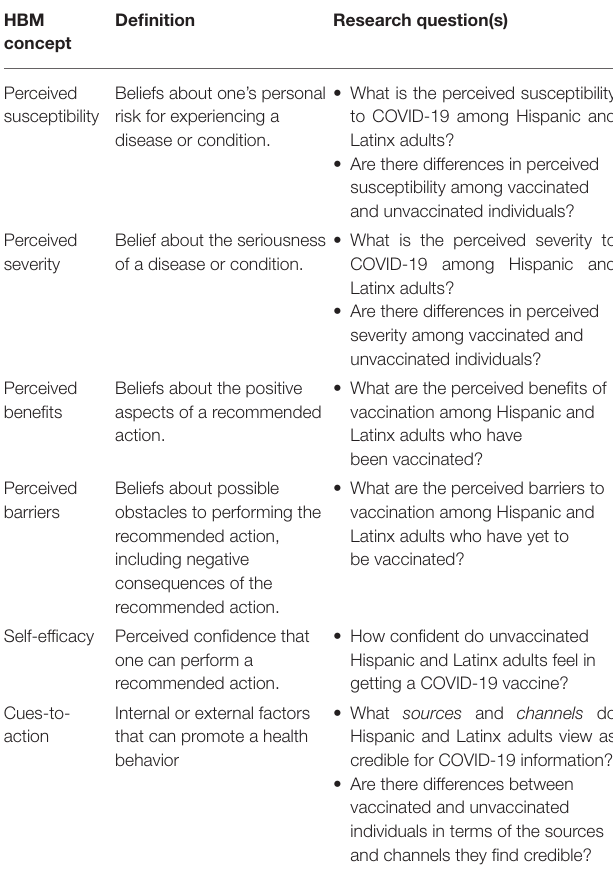
TABLE 1 | Health belief model concepts, definitions, and study research